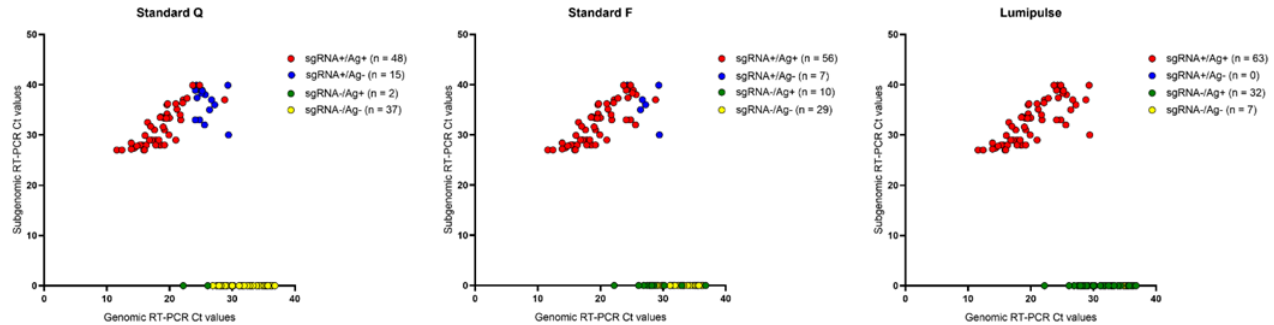
Figure 2. Distribution of NPS samples from 82 symptomatic COVID-19 patients tested for (reverse transcription-PCR) sgRNA and (Standard Q, Standard F, or Lumipulse) antigen detection according to number of days of symptoms before sample collection. Colors indicate groups of results stratified as sgRNA positive/Ag positive (red), sgRNA positive/Ag negative (blue), sgRNA negative/Ag positive (green), or sgRNA negative/Ag negative (yellow). Ag, antigen; COVID-19, coronavirus disease 2019; Ct, cycle threshold; NPS, nasopharyngeal swab; sgRNA, subgenomic RNA.